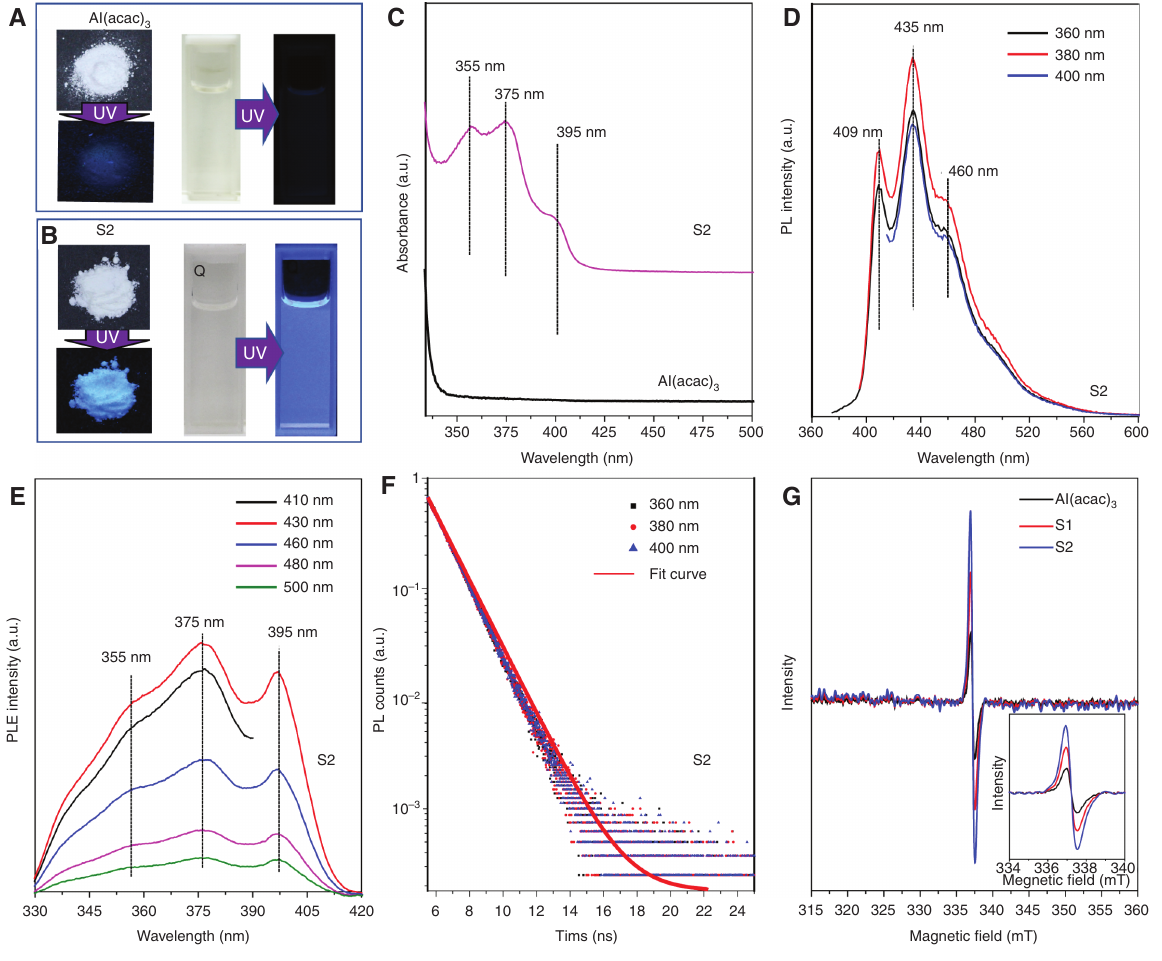
Figure 4: Optical properties of S2. The photographs of (A) precursor and (B) sample (S2) under sunlight and 365-nm UV lamp as well as its corresponding (C) UV-vis absorption spectra. (D) PL spectra measured at different excitation wavelengths ranging from 360 to 400 nm. (E) PL excitation spectra monitored at different emission wavelengths from 410 to 500 nm. (F) Time-resolved PL decays and fitted curves of the light emission at 460 nm for S2 under different excitation wavelengths of 360, 380, and 400 nm. (G) X-band (9.07 GHz) EPR spectra of Al(acac) their enlarged-scale spectra given as an